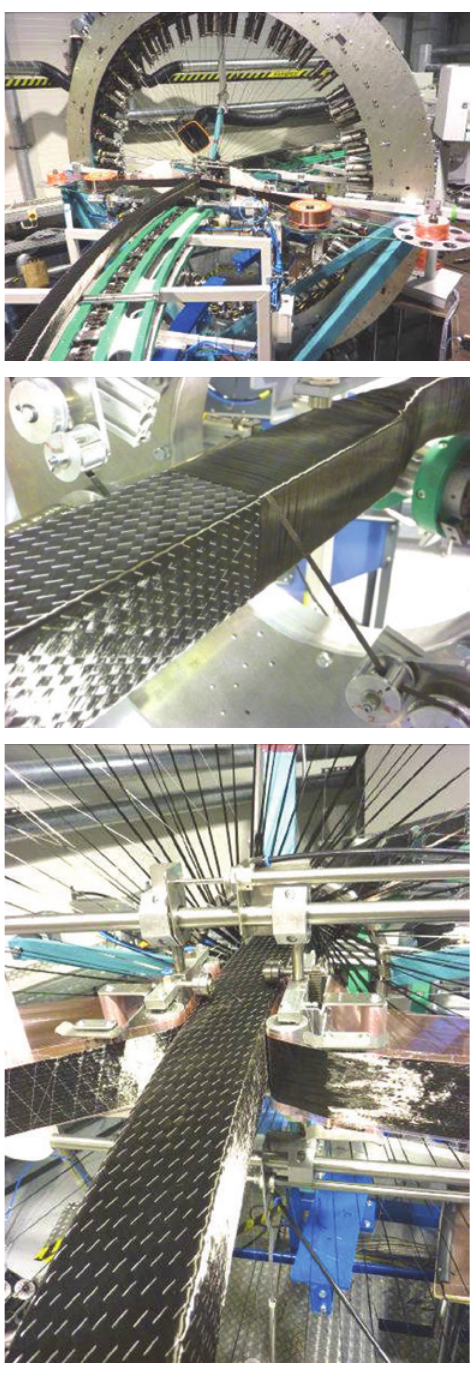
Figure 5: Processing steps of BraF, a braiding process (top) com- bined with winding of 90 ° layers (center) and UD tape integration (bottom). Source: Airbus Group Innova